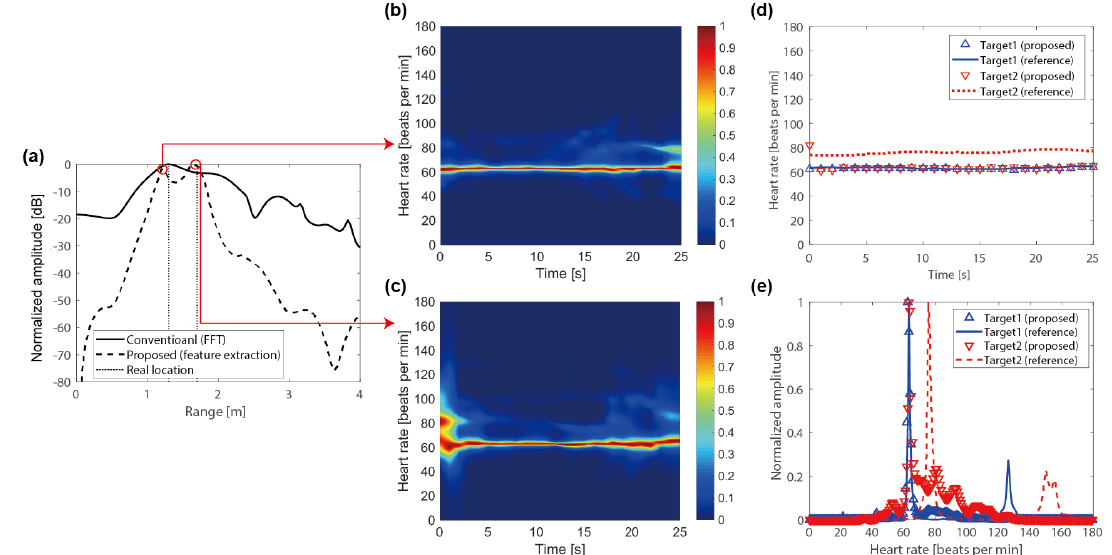
Figure 11. Measurement results for two targets: ( a ) range estimation for two targets at distances of 130 to 170 cm; ( b ) real-time heart rate for the front target at a distance of 130 cm; ( c ) real-time heart rate for the rear target at a distance of 170 cm; ( d ) comparison between the proposed method and the reference sensor in terms of the real-time data; and ( e ) comparison between the proposed method and the reference sensor in terms of the total